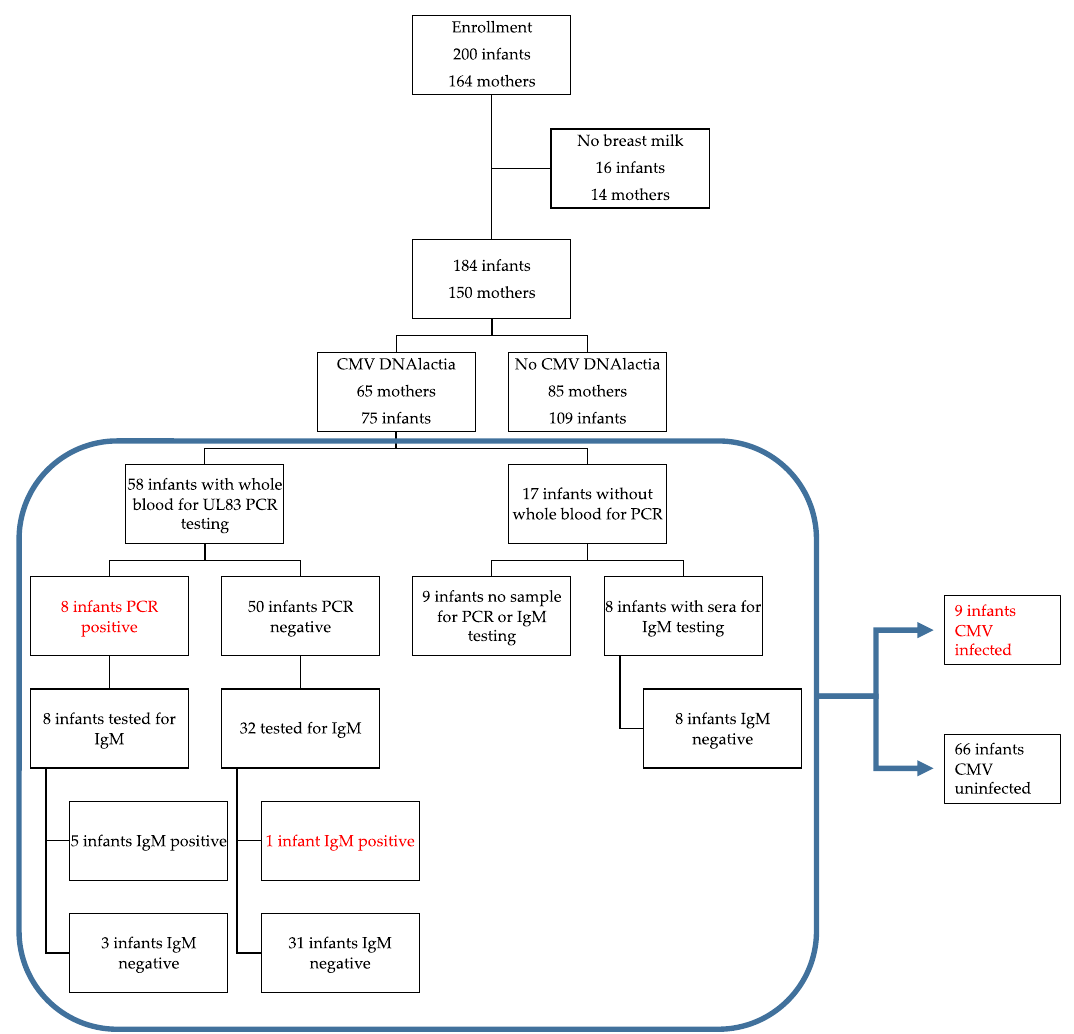
Figure 1. Study flow diagram. This diagram includes maternal DNAlactia, evidence for breast milk transmission of cytomegalovirus (CMV) to the infant, and the method(s) used to determinate transmission of CMV. Red font indicates infants that were determined to be CMV-infected during their NICU hospitalization.